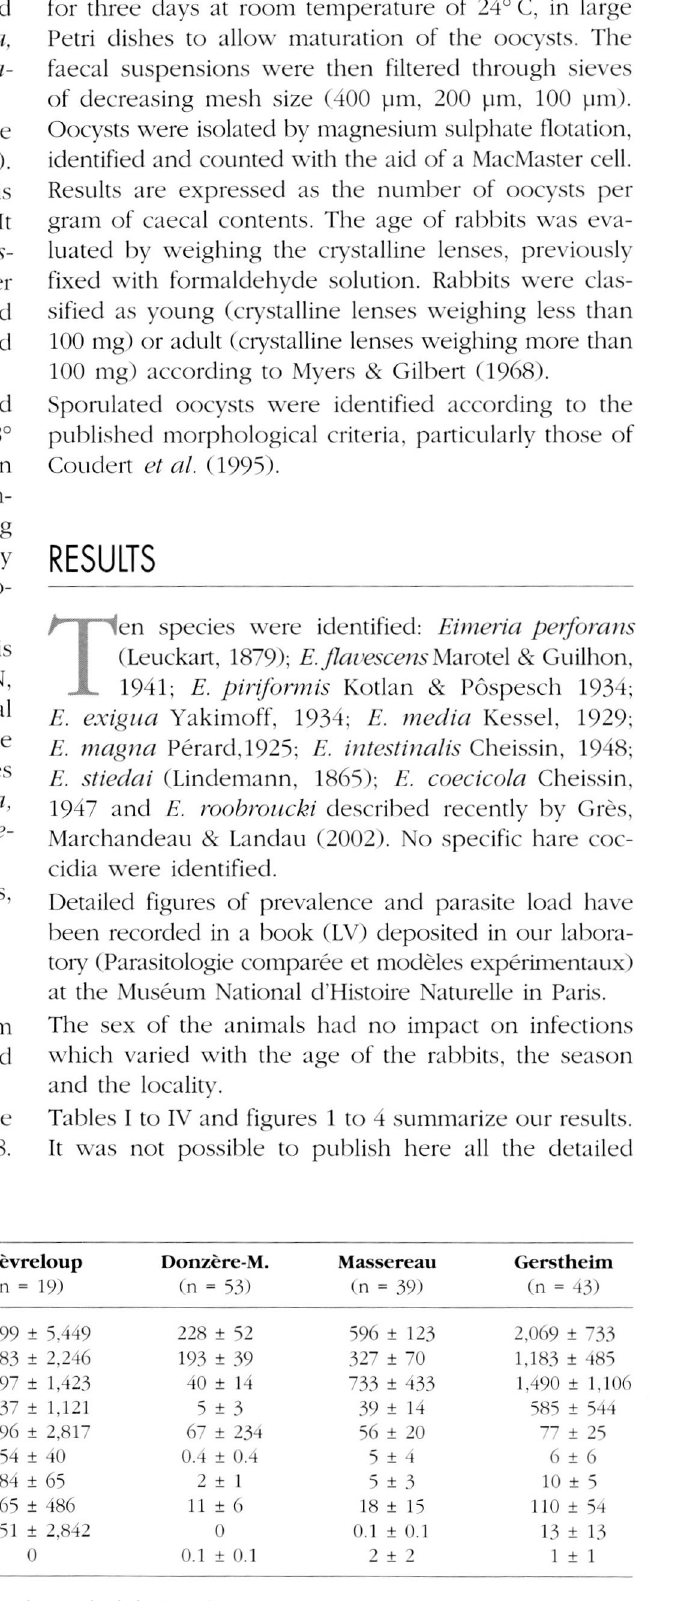
Table I. - Mean parasitic load of adult rabbits according to locality (± standard